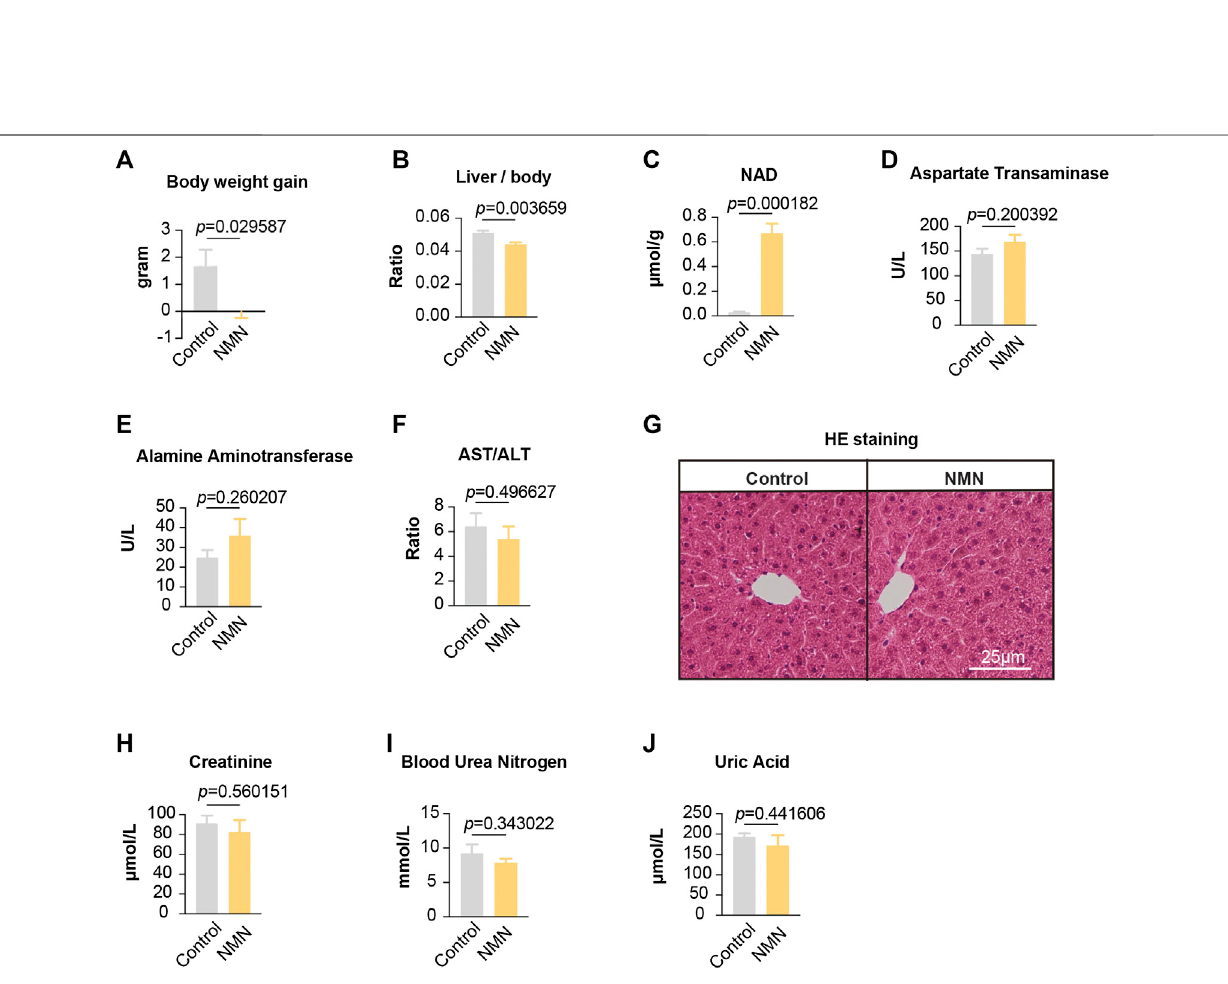
Frontiers in Pharmacology |